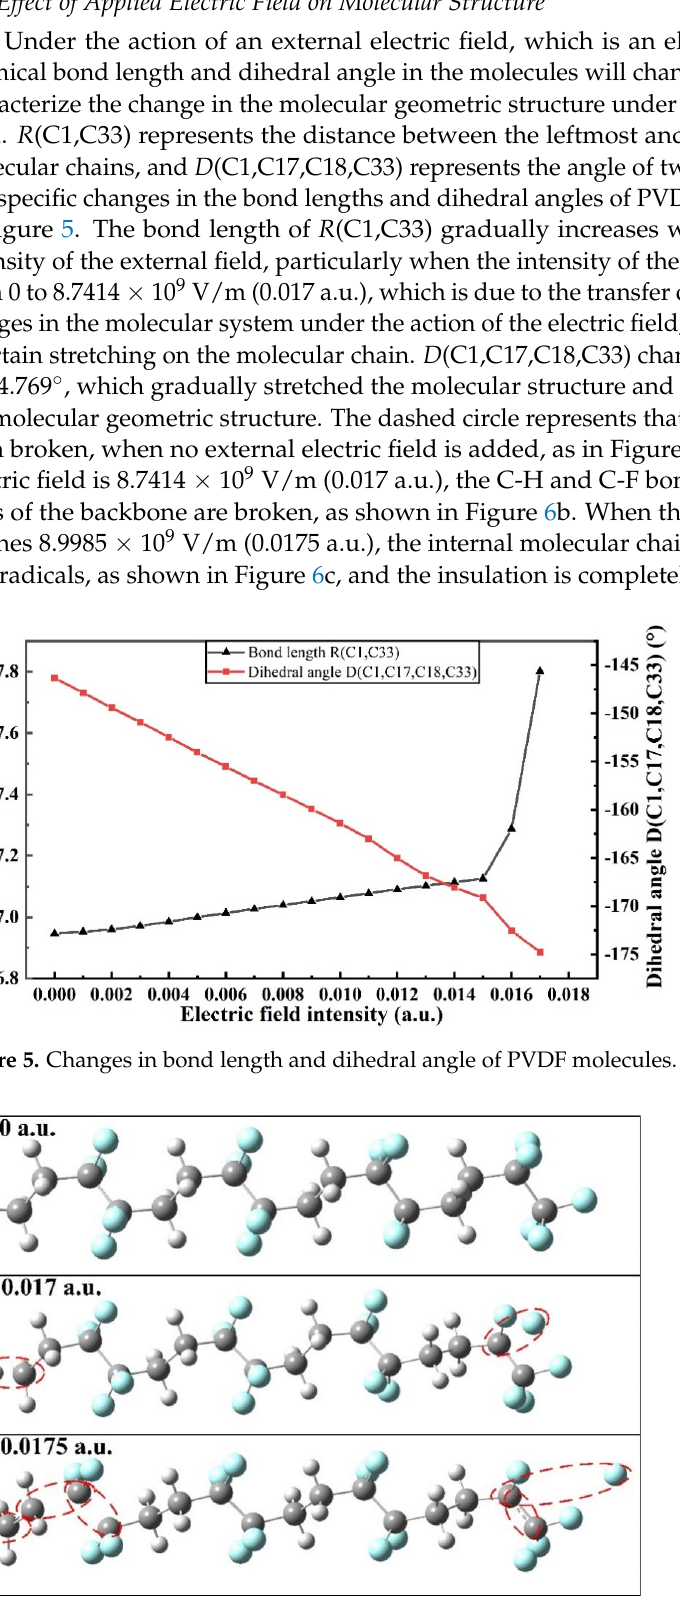
Figure 6. Molecular geometry at different electric field intensities.